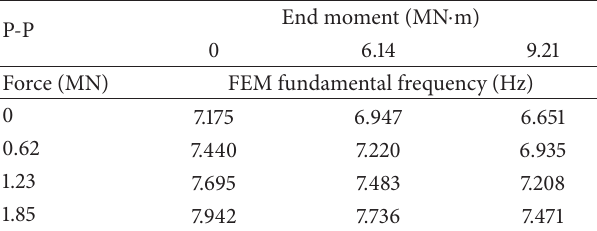
Table 4: Fundamental frequencies for pinned-pinned boundary condition (P-P), when force and end moment are applied; a 40- element FEM model is used.